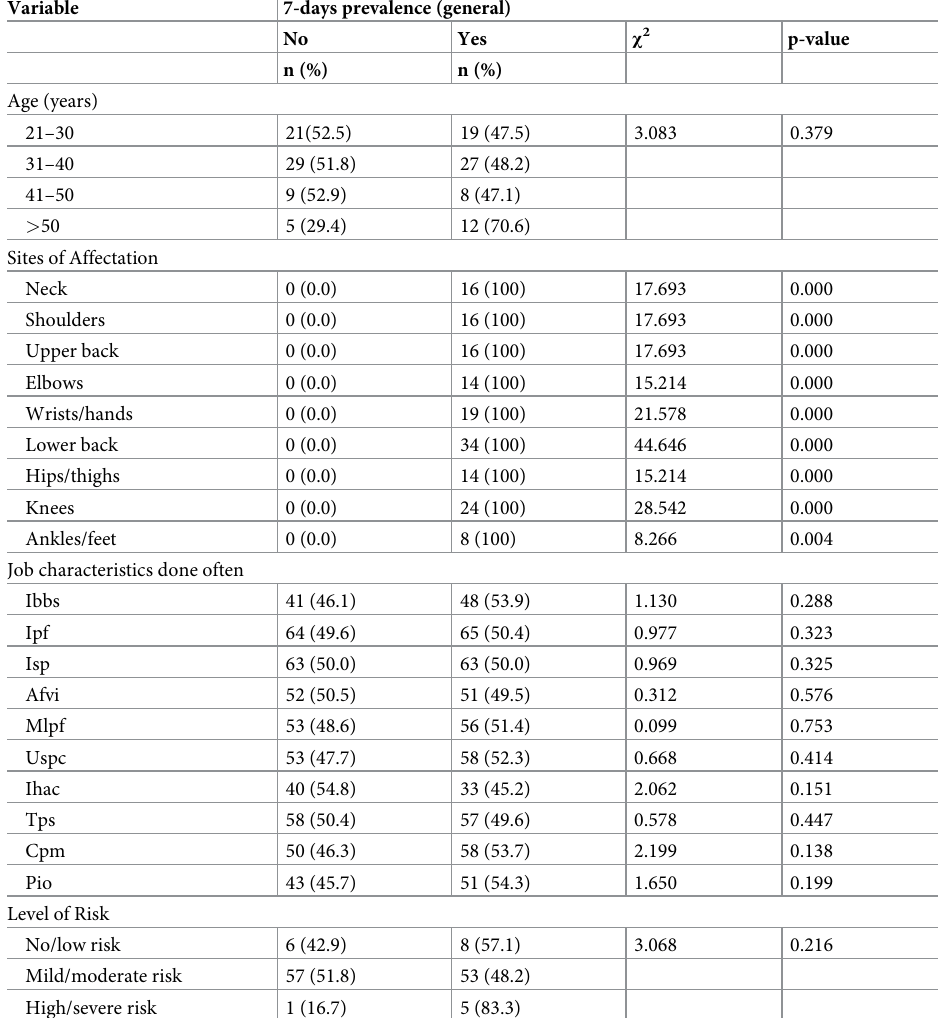
Table 5. Chi-square test of association between seven-days prevalence of work-related musculoskeletal disorders and each of age, sites of affectation, job characteristics and risk factors (N = 130).